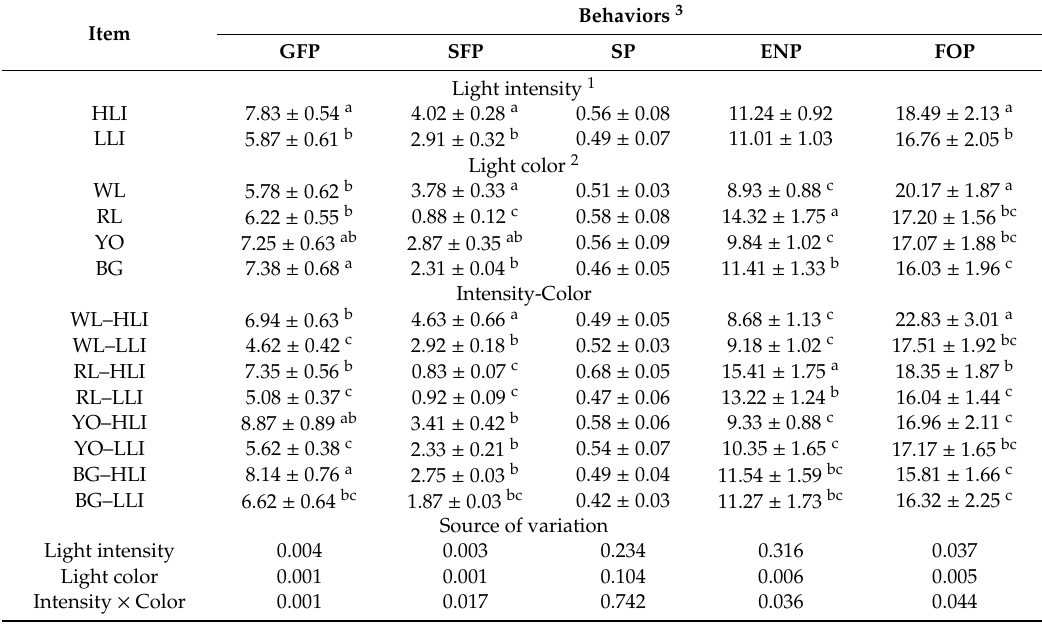
Table 2. Means ( ± SE) of pecking behaviors of hens in response to light colors and light intensities * .